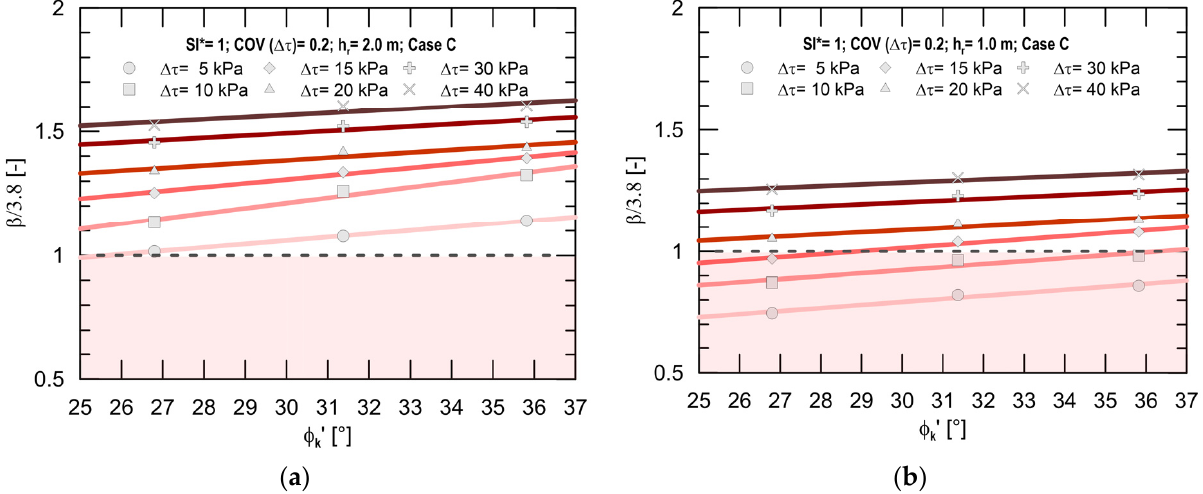
Figure 9. β values normalised with respect to the threshold for varying ∆ τ and ϕ k ′ , for seismic case C and COV ( ∆ τ ) = 20%, in case of h r = 2 m ( a ) and h r = 1 m ( b ), respectively.